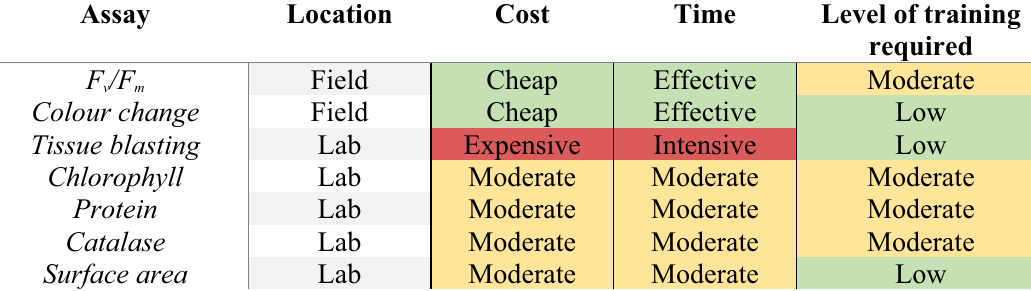
Table 2. Costs and benefits of measures of coral thermal tolerance. Benefit classification used based on 100 samples; financial; Cheap < $200, Moderate $200–$600, Expensive > $600. Time; Effective < 5 h, Moderate 5–10 h, Intensive > 10 h per 100 samples. Level of training required; low = little to no instruction required, easy to do from protocol, no specialised laboratory skills required; Moderate = some basic laboratory skills required, operator generally supervised a couple of times then works from protocol, special instruction in equipment use. Hourly rate used for time cost is $33 AUD per hour. See Supplementary Material S6.1 for an overview and price-guideline for the equipment required for each of these assays. Cell colours reflect coding for high (red; expensive, intensive), medium (yellow; moderate) and low (green; cheap, effective, low) across